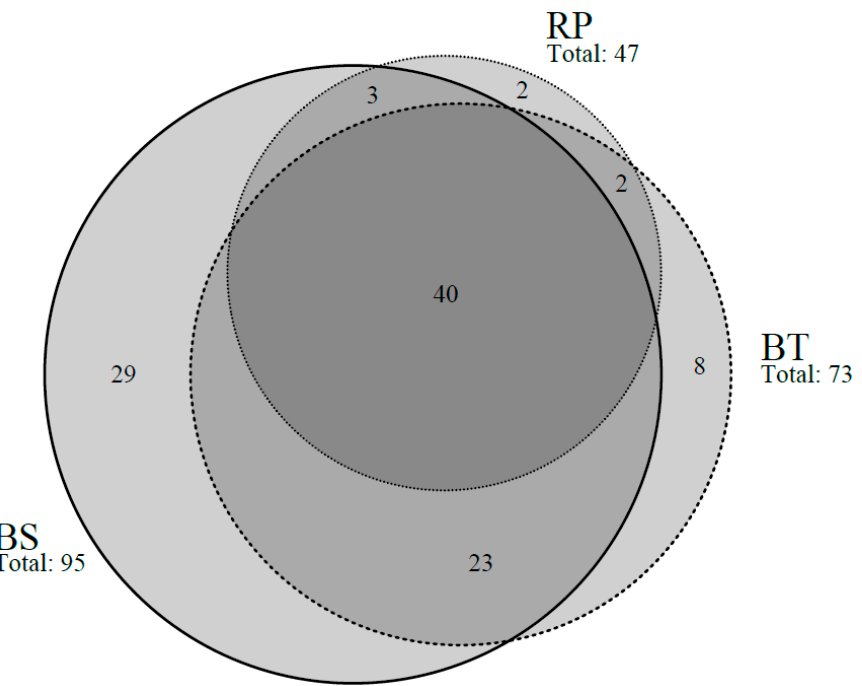
Figure 2. Euler diagram representing the catch composition in number of species for beach seine (BS; 25 and 50-m), beam trawl (BT) and Riley push net